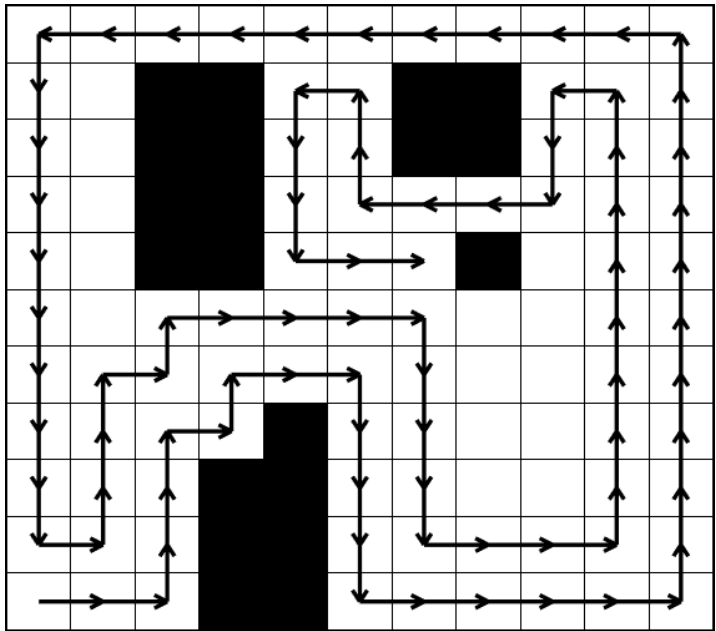
Figure 12. Path plan of inner spiral coverage.